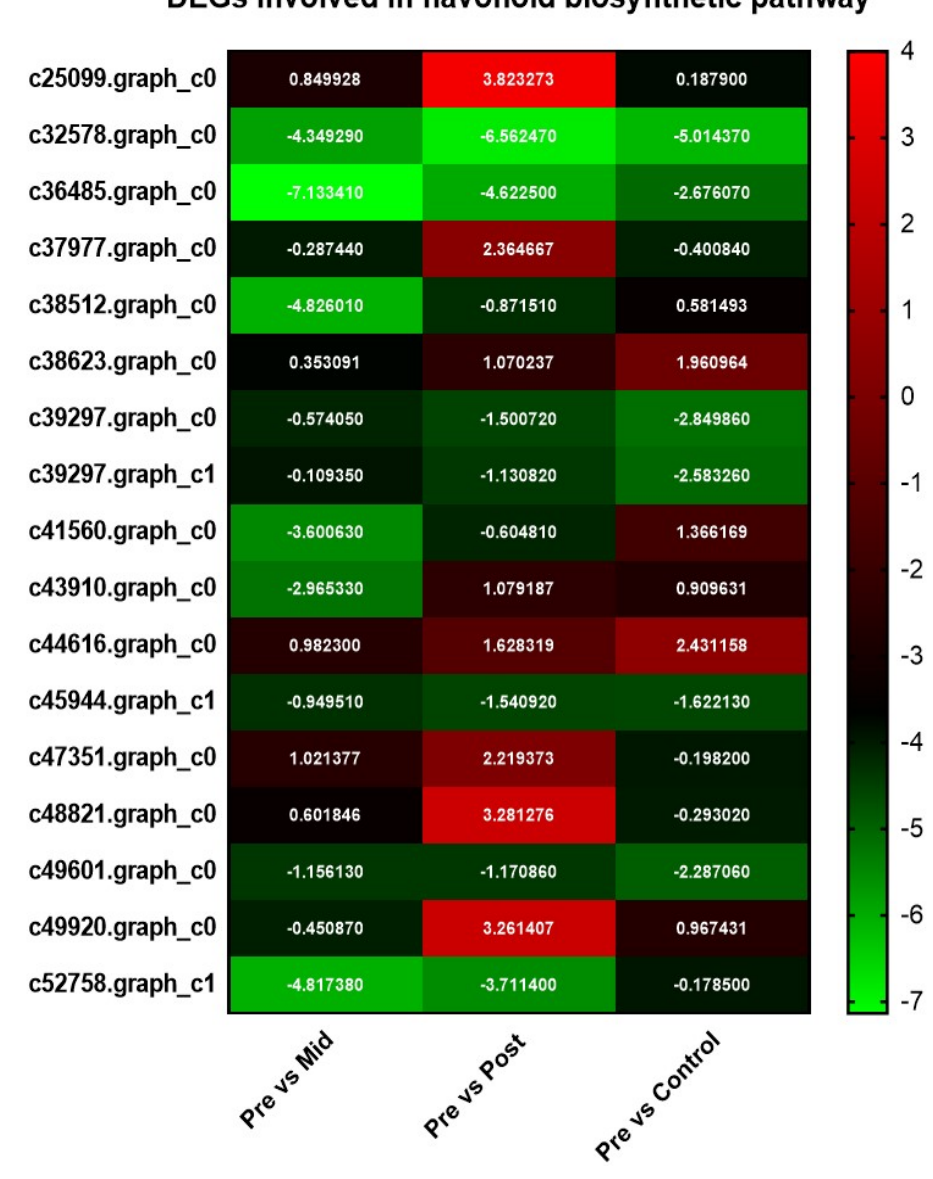
Figure 3. Heat map of DEGs involved in flavonoid biosynthesis pathway in the stem of water dropwort under mid − blanched, post − blanched, and control conditions.